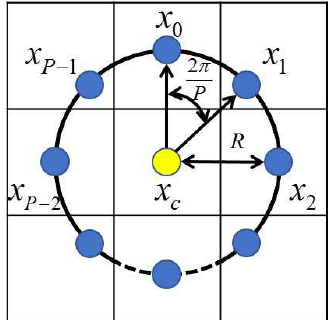
Figure 4. Central pixel x c and its P circularly and evenly spaced neighbors x 0 ,..., x P − 1 with radius R